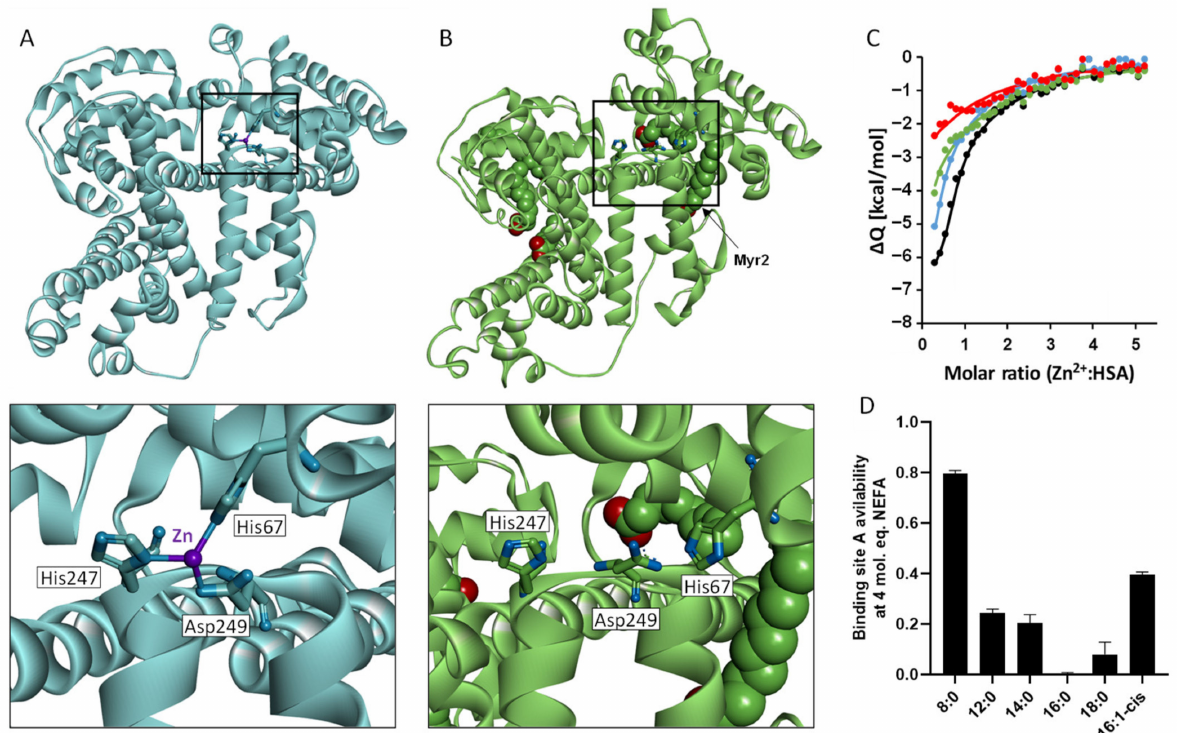
Figure 2. Influence of fatty acids on HSA structure and zinc binding. ( A ). X-ray crystal structure of HSA with zinc bound (PDB: 5IJF). Zinc binds in a tetrahedral geometry at site A involving the side chains of His67, His247, and Asp249. ( B ). X-ray crystal structure of HSA with myristate bound (PDB: 1BJ5). The binding of myristate at the FA2 site causes movement of zinc-binding residue His67 away from His247 and Asp249. ( C ). Isothermal titration calorimetry showing the effect of fatty acid loading on zinc binding to HSA. In the experiments 1.5 mM ZnCl 2 was titrated into 60 µ M HSA, in the presence of either 0 (black), 3 (blue), 4 (green), or 5 (red) mol. eq. of myristate in a buffer containing 50 mM Tris, 140 mM NaCl, pH 7.4. ( D ). Bar chart representing the availability of binding site A in the presence of 4 mol. eq. of various fatty acids. All except octanoate had large effects on Zn 2+ binding to the protein. Data for parts C and D were taken from Sobczak et al.